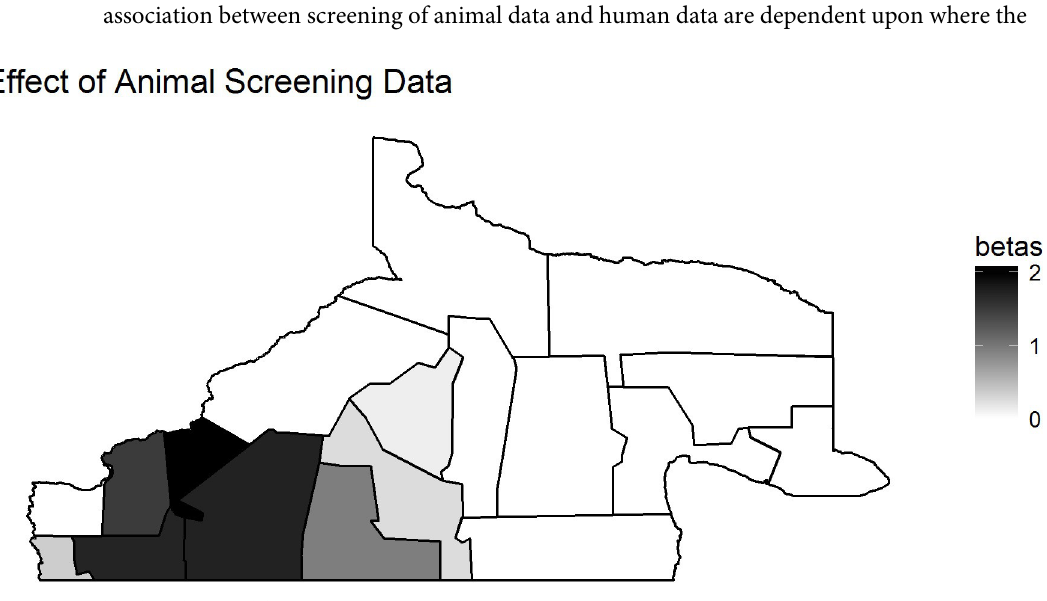
Fig 8. β 2010 i values based on Model